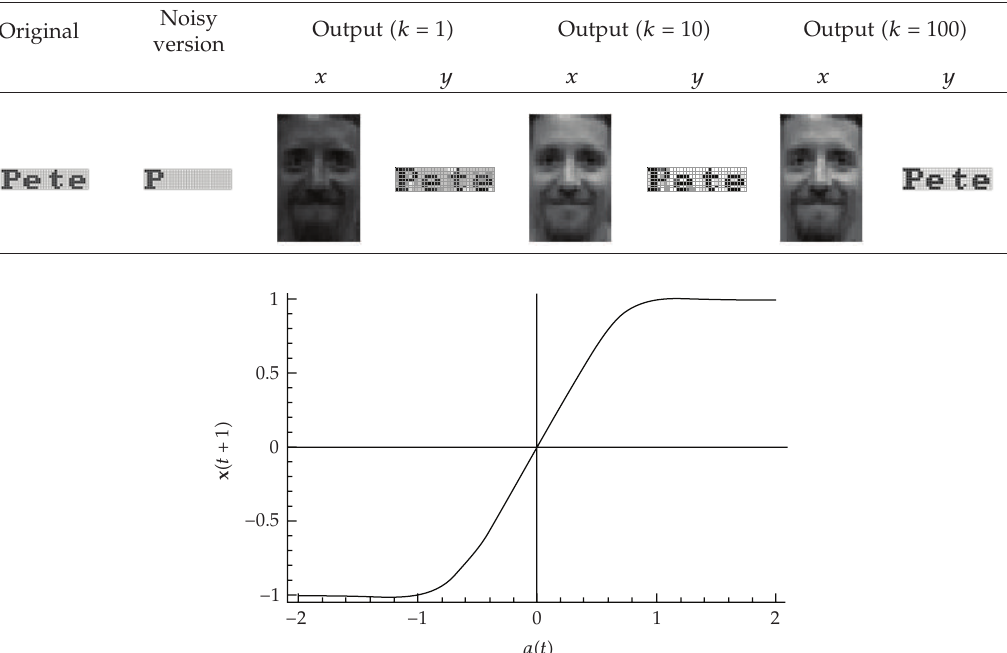
Table 4: Network recall for missing name parts.